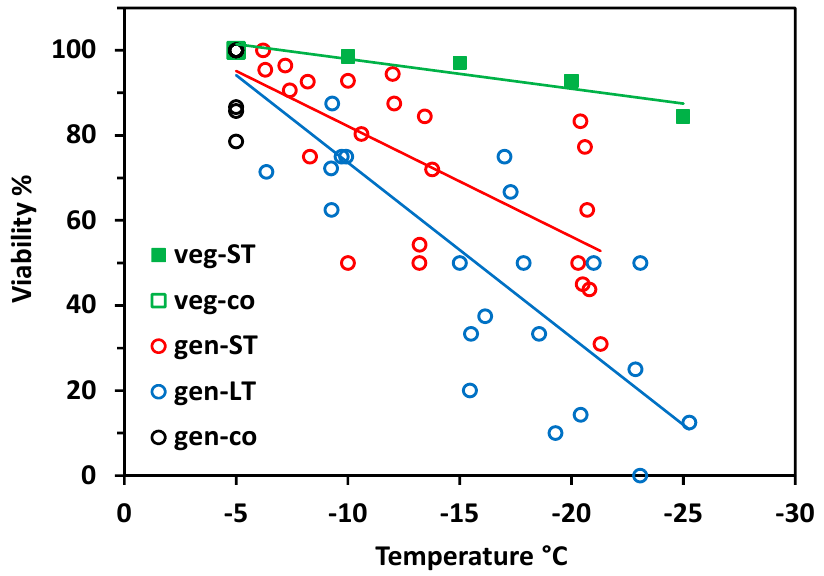
Figure 7. Saxifraga bryoides L. Percent viability (TTC test) of control buds (co) and of vegetative (veg) and generative (gen) buds in the short-time (ST) and long-time (LT) experiment in winter. Green squares: each symbol refers to the total of investigated vegetative buds pooled from 8–12 individuals per test temperature in ST experiment 1. Generative buds in control individuals (open black circles) and in individuals after short-time (red circles) and long-time (blue circles) exposure at different freezing temperatures in experiment 2; each symbol refers to a single individual. Trend lines indicate linear regressions.